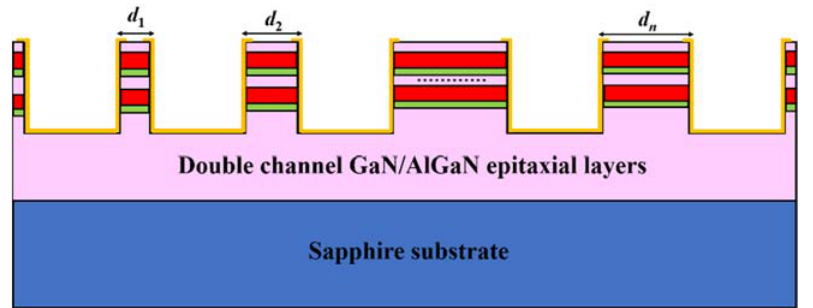
Figure 4. The cross section of the side ohmic contact mode. The pink region refers to the GaN layer, the red region refers to the AlGaN layer, and the green region refers to the AlN layer.